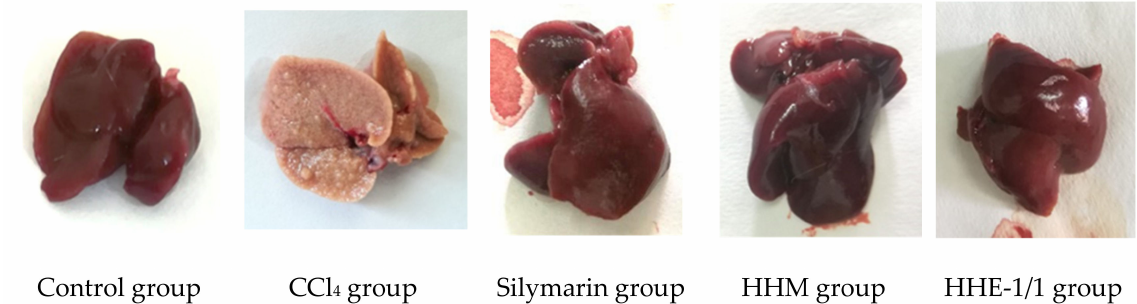
Figure 1. Photograph of rats’ livers of CCl 4 -induced liver fibrosis model. The microscopic images of the liver in the control group shows an image of normal liver tissue with a structure of cell bands, and rafts surrounding the central vein of the lobule. Between the bands, the liver rafts are the sinusoid. Some liver cells are slightly degenerated. The portal area contains the bile duct, portal vein, and hepatic artery (Figure 2).